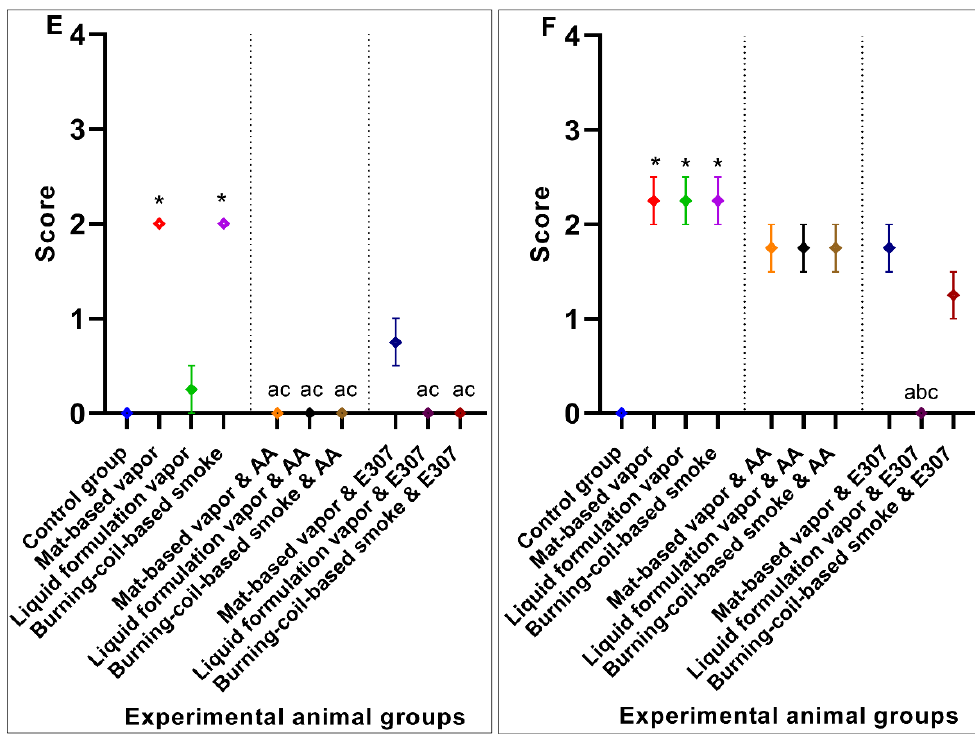
Figure 9. Effects of ascorbic acid (AA) and α -tocopherol (E307) on pyrethroid-induced toxicity in the lungs of the animals showing edema ( A ), enlargement of air space ( B ), hyperemia ( C ), infiltration of CT (connective tissue) by inflammatory cells ( D ), lymphocyte infiltration aggregates ( E ), and occlusion by hyaline ( F ). Values are expressed as mean ± S.E. The Kruskal–Wallis non-parametric test was used for group differences, and Dunnett’s corrections of the significance level for multiple comparisons were performed. The significance levels ( p -values) using Dunnett’s corrections for all the variables were as follows: graph ( A ): *— p = 0.01 vs. the control group, while the letter c denotes p = 0.01 compared to the animals exposed to burning-coil-based smoke; graph ( B ): **— p = 0.003 vs. the control group, while the letter c denotes p = 0.03 compared to the animals exposed to burning-coil-based smoke; graph ( D ): **— p = 0.006 vs. the control group, while the letter b denotes p = 0.06 compared to the animals exposed to liquid formulation vapor; graph ( E ): *— p = 0.04 vs. the control group, while the letters a and c denote p = 0.04 compared to the animals exposed to the mat-based and burning-coil-based smoke; graph ( F ): *— p = 0.03 vs. the control group, while the letters a–c denote p = 0.03 compared to the animals exposed to the mat-based vapor, liquid formulation vapor, and burning-coil-based smoke.